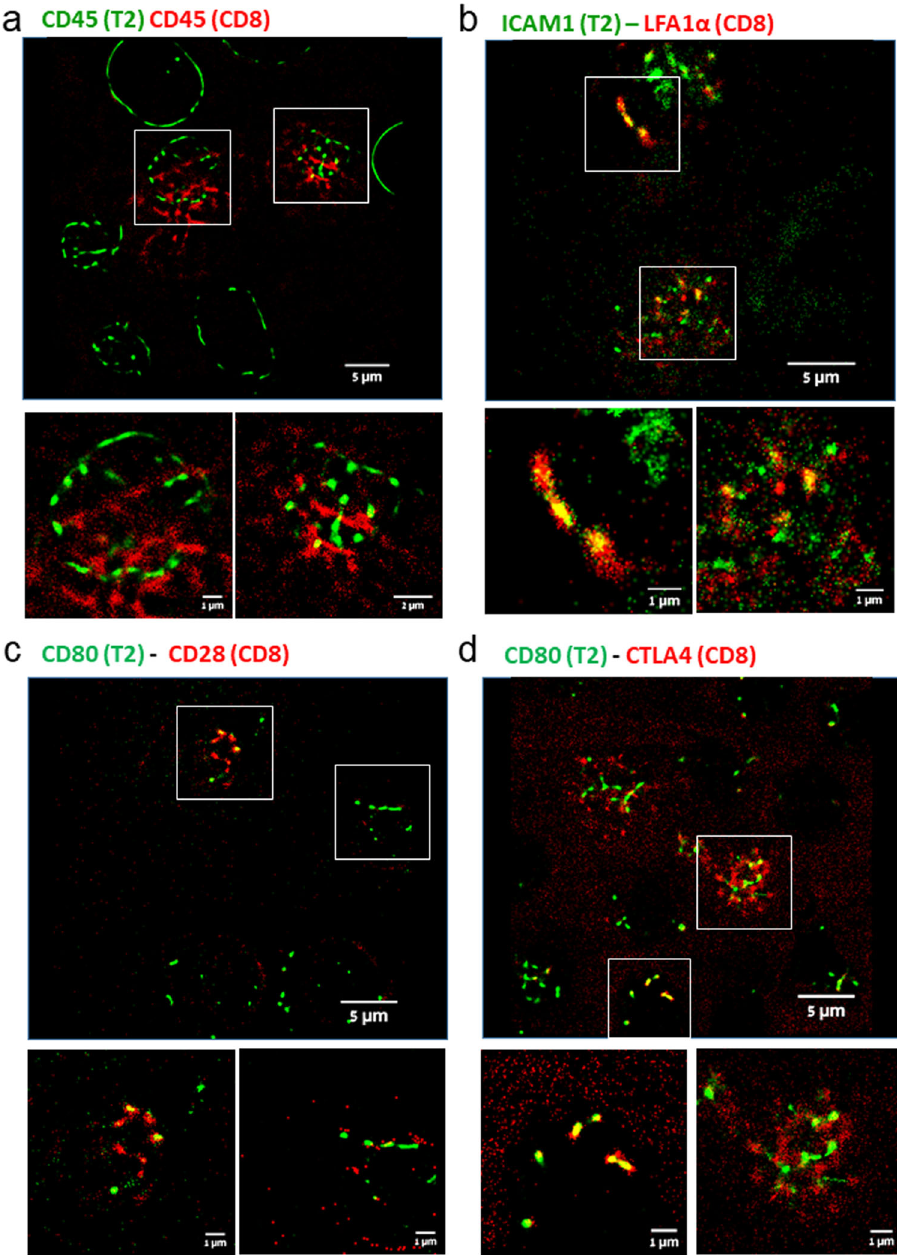
Fig. 3 Molecular organization and interactions at the IS. a – d dSTORM images of cell conjugates of CD8 + T cells with T2 cells loaded with the activating peptide NY-ESO-1. a The CD8 + T (red) and T2 (green) cells were both stained for CD45 (with Alexa647 and Atto488 secondary antibodies, respectively). A representative fi eld (top) and two zoom images of a single conjugate (bottom) are shown. b The CD8 + T cells (red) were stained for LFA1 α , and T2 (green) cells were stained for ICAM1. A representative fi eld (top) and two zoom images of single conjugates (bottom) are shown. c The CD8 + T cells (red) were stained for CD28, and T2 (green) cells were stained for CD80. A representative fi eld (top) and two zoom images of single conjugates (bottom) are shown. d The CD8 + T cells (red) were stained for CTLA4, and T2 (green) cells were stained for CD80. A representative fi eld (top) and two zoom images of single conjugates (bottom) are